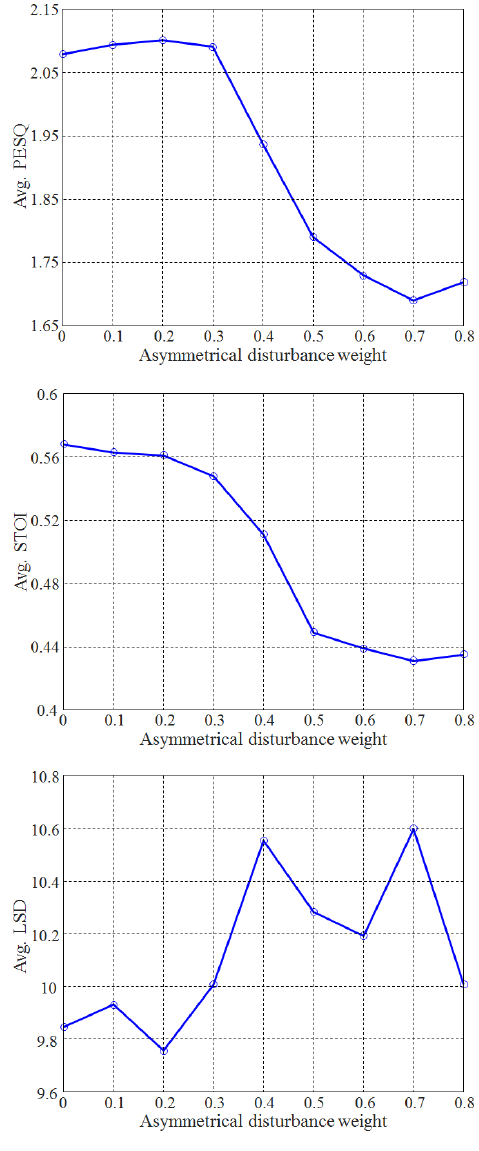
Figure 5. Objective evaluation results according to the weights of the asymmetrical disturbance. ( Top ): Average PESQs. ( Middle ): STOIs. ( Bottom ):